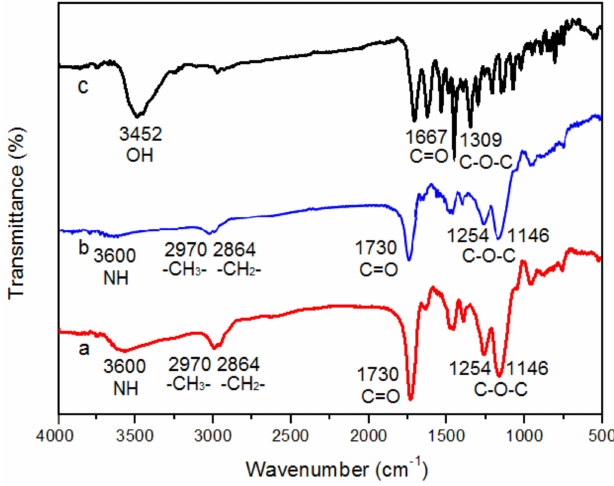
Figure 5. FT-IR spectra of ECB-MICMs ( a ), NICMs ( b ), and ECB ( c